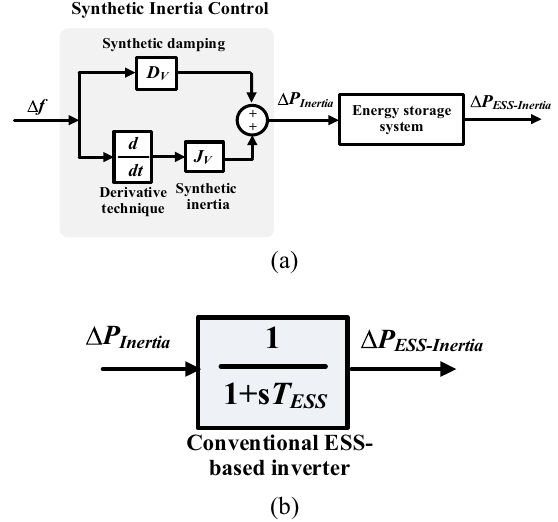
Fig. 5 Dynamic models: a SIC system based on ESS and